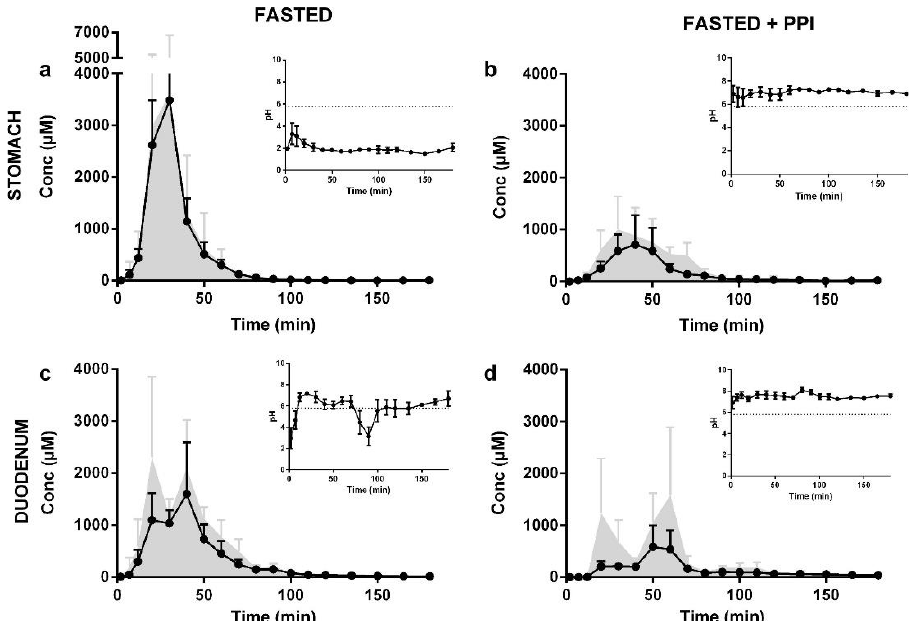
Figure 7. Gastric and duodenal concentration – time profiles for indinavir following administration of Crixivan in a fasted state ( a , c ) and a fasted state with concomitant use of the PPI esomeprazole ( b , d ). One capsule of Crixivan was orally ingested with 240 mL of tap water. Black lines and gray areas represent the dissolved and total indinavir content (solid + solute expressed as concentration), respectively. Inserts depict the corresponding pH profiles as a function of time. The dashed line represents the pKa of indinavir (5.8). ( a ) Fasted state, stomach; ( b ) fasted state with concomitant PPI use, stomach; ( c ) fasted state, duodenum; ( d ) fasted state with concomitant PPI use, duodenum (mean + S.E.M., n = 5). Reproduced with permission from European Journal of Pharmaceutics and Biopharmaceutics , 109, Rubbens et al. “Gastrointestinal dissolution, supersaturation and precipitation of the weak base indinavir in healthy volunteers”, 122– 129, [34], Copyright Elsevier (2016).